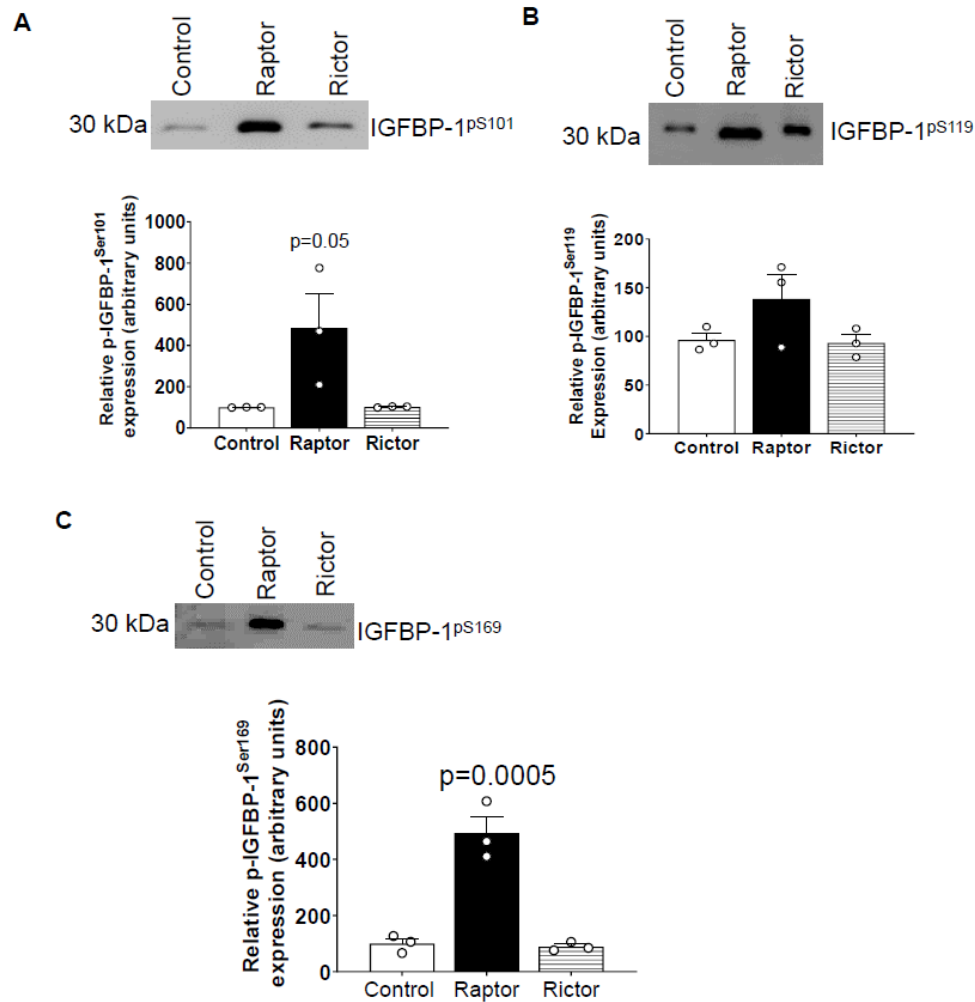
Figure 3. Site-specific IGFBP-1 phosphorylation in CM from HepG2 cells treated with CM from PHT cells with the control (non-coding siRNA), RAPTOR, and RICTOR siRNA. Equal aliquots of CM ( μL ) from HepG2 treated with CM from PHT cells with the control (non-coding siRNA), RAPTOR , and RICTOR siRNA was used to determine site-specific IGFBP-1 phosphorylation. CM (40 µL) was loaded on 1-D gels for Western blot for pSer101 ( A ), pS119 ( B ), and pS169 ( C ) IGFBP-1. The band intensity of each sample was normalized to the control (average arbitrarily set to 100). Data were presented in the bar figure as Mean + SEM, analyzed using one-way ANOVA, and corrected with Bonferroni Multiple Comparison tests; p < 0.05 was considered significant.